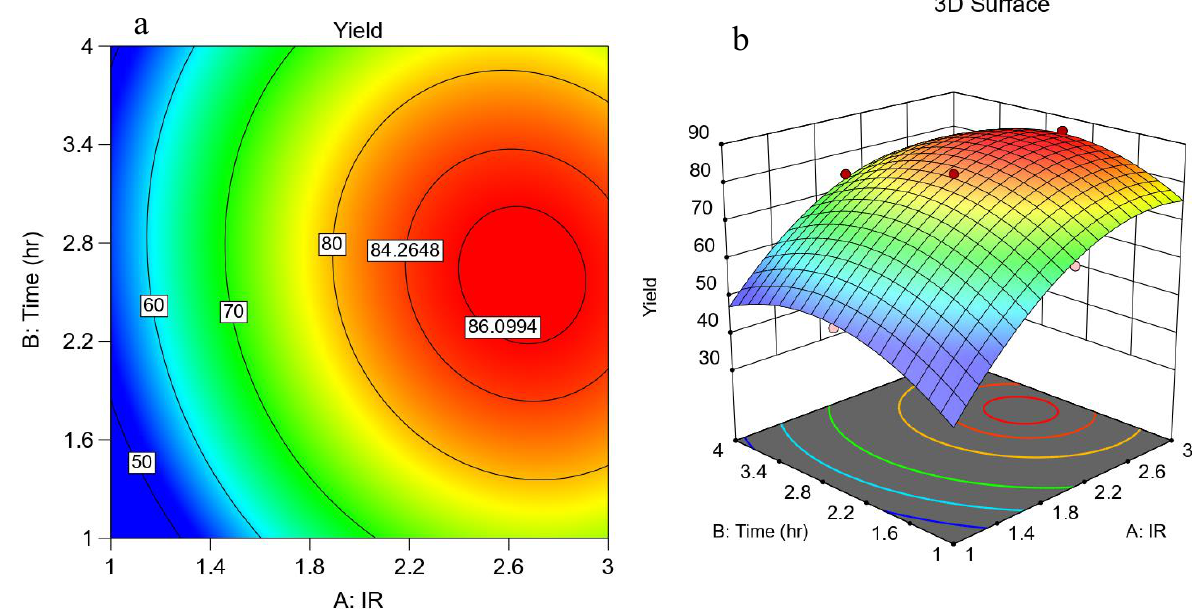
Fig. 5. The interaction between the impregnation ratio and time (a) contour (b) 3D